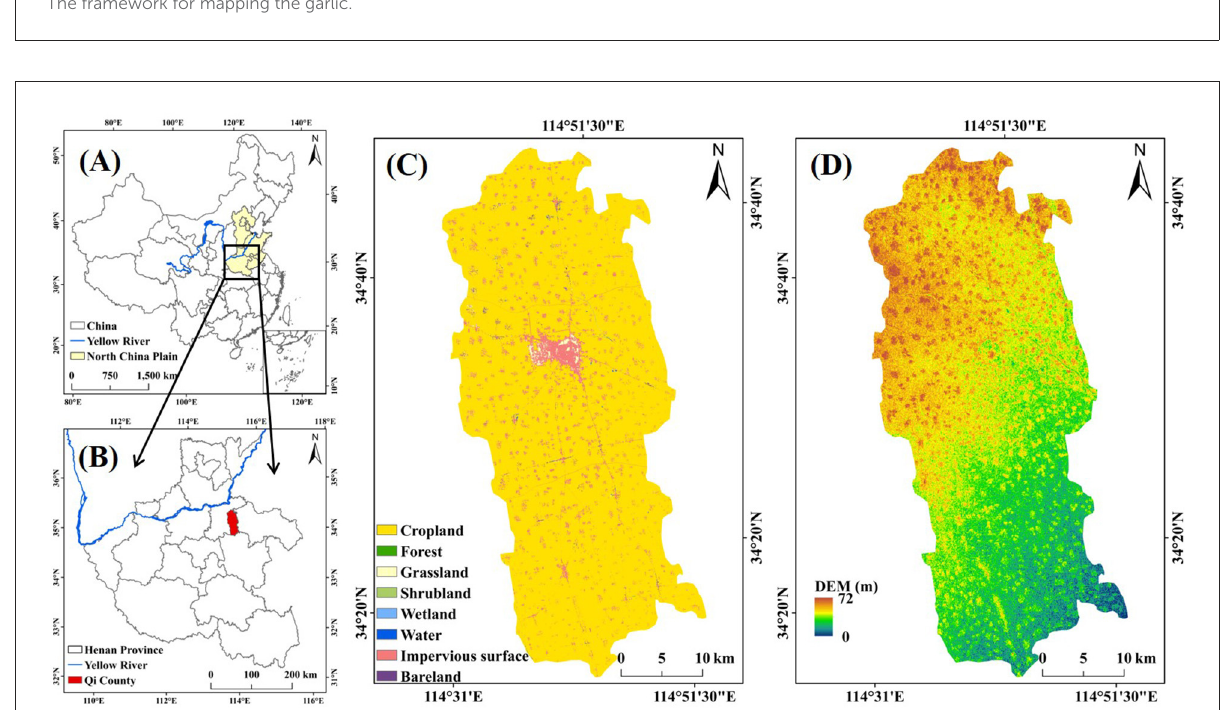
FIGURE1 The framework for mapping the